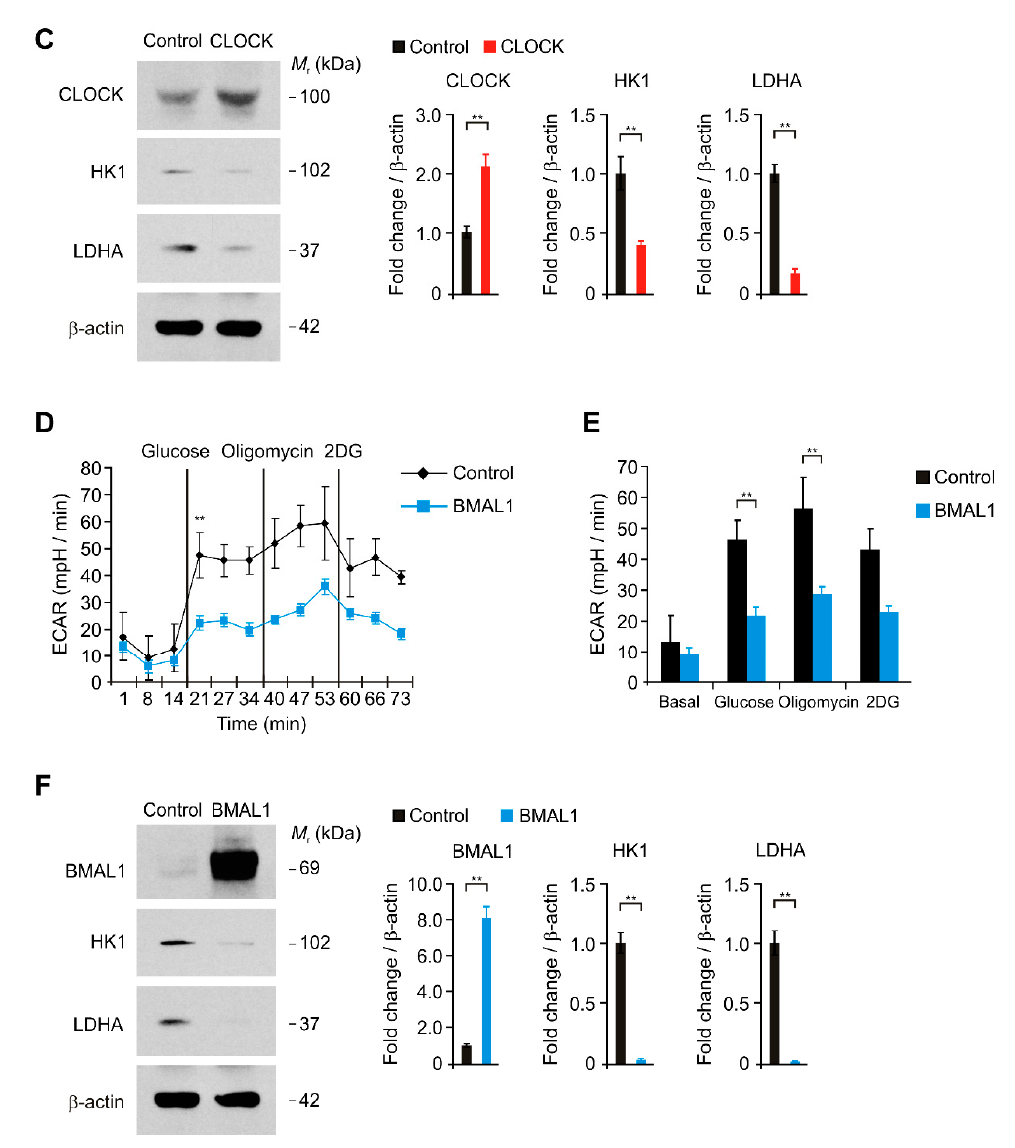
Figure 2. The elevation of CLOCK and BMAL1 suppresses aerobic glycolysis and lactate production by reduction in hexokinase 1 (HK1) and lactate dehydrogenase A (LDHA) protein levels in human astrocytes. ( A ) The levels of extracellular acidification rate (ECAR) for glycolysis of glucose and ( B ) quantification of ECAR levels in control and CLOCK-overexpressing (CLOCK) human astrocytes. Data are representative of three independent experiments. Data are mean ± SEM. * p < 0.05 using the two-tailed Student’s t -test. ( C ) Representative immunoblot analysis for CLOCK, HK1, LDHA (left) and quantification for CLOCK, HK1, LDHA protein levels (right) in control and CLOCK-overexpressing (CLOCK) human astrocytes. For immunoblots, β -actin was used as loading control. Data are representative of three independent experiments. Data are mean ± SEM. ** p < 0.01 using the two-tailed Student’s t -test. ( D ) The levels of extracellular acidification rate (ECAR) for glycolysis of glucose and ( E ) quantification of ECAR levels in control and BMAL1-overexpressing (BMAL1) human astrocytes. Data are representative of three independent experiments. Data are mean ± SEM. * p < 0.05 using the two-tailed Student’s t -test. ( F ) Representative immunoblot analysis for BMAL1, HK1, LDHA (left) and quantification for BMAL1, HK1, LDHA protein levels (right) in control and BMAL1-overexpressing (BMAL1) human astrocytes. For immunoblots, β -actin was used as loading control. Data are representative of three independent experiments. Data are mean ± SEM. ** p < 0.01 using the two-tailed Student’s t